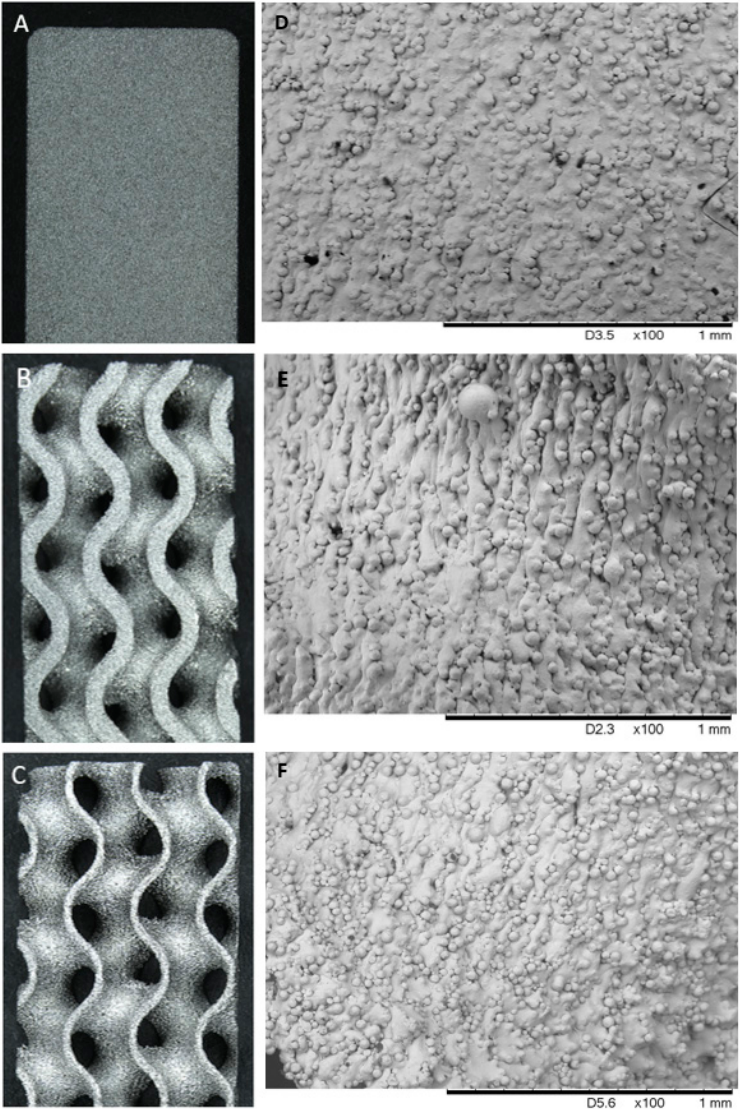
Figure 1. Stereozoom surface images of a LPBF Ti6Al4V produced; ( A ) solid sample; ( B ) 60% porous gyroid sample; ( C ) 80% porous gyroid sample. SEM surface images at 100× magnification of ( D ) solid sample; ( E ) 60% porous gyroid sample; ( F ) 80% porous gyroid sample. SEM images displayed increased definition and proportion of beads and “rippling” on the surface of both porous test